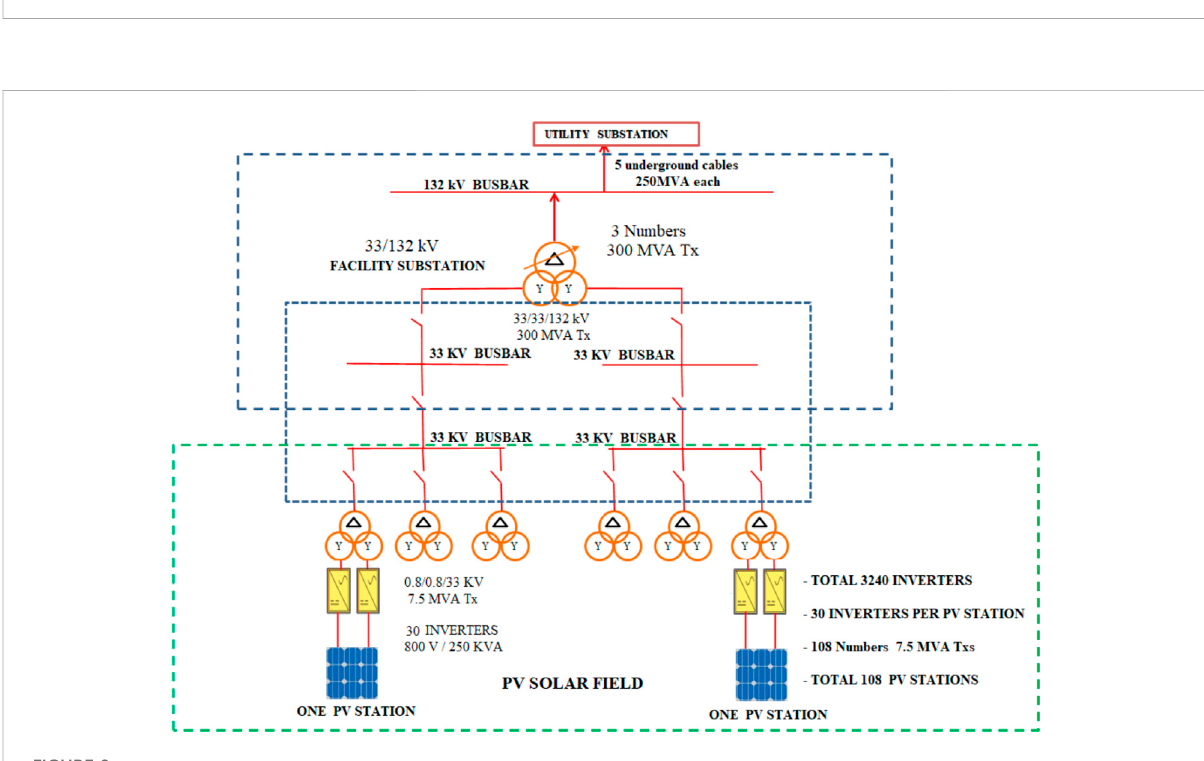
FIGURE 9 PV farm in